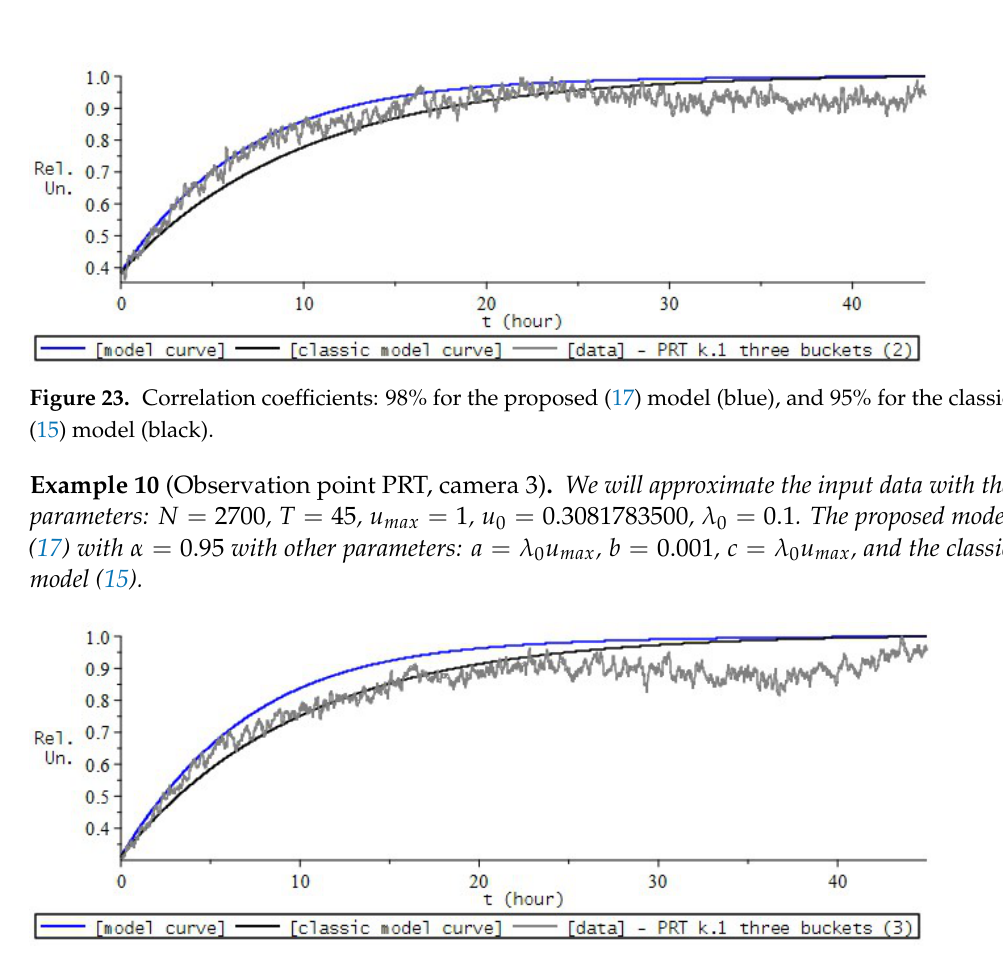
Figure 24. Correlation coefficients: 98.2% for the proposed (17) model (blue), and 96.4% for the classic (15) model